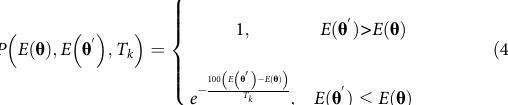
where T k is the temperature at iteration time k . That is, we always accept new con fi gurations when there is improvement; however, worse con fi gurations also have a chance to be accepted, depending on the temperature and the gap of E ( θ ). Notice that, as k approaches k max (i.e., temperature T approaches 0), the probability of accepting worse con fi gurations gradually decreases to 0. The iteration repeats and is terminated if the con fi guration remains unchanged for a given period of time. For SA optimization with selective threshold θ , we set the maximal iteration time as 1 ×10 5 and terminated the algorithm if θ was stable for 500 iterations. We performed 100 independent optimizations starting from different initial values, and selected the best θ as the fi nal choice. In Fig. 5a, we present the comparison of retrospective forecast accuracy for 95 cities in the United States. Results are displayed for the EAKF, original EAKFC in which error correction is applied indiscriminately, and optimized EAKFC that adaptively applies error correction according to the selective threshold. As shown in Fig. 5a, the optimization improves the peak timing accuracy during the predicted lead time of 3 weeks to 1 week, which is a critical time window for timely prediction. Peak timing accuracy between 0 week to − 4 week is improved as well. The selective rule optimized over all in fl uenza seasons in 95 cities is displayed in the inset of Fig. 5a. For predictions with a longer lead time, only a small fraction of ensemble members are updated with error correction. As the predicted outbreak peak lead time approaches 0, error correction is applied to more ensemble members. If the predicted peak lead time is beyond − 4 weeks, no error correction is needed because the EAKF makes accurate